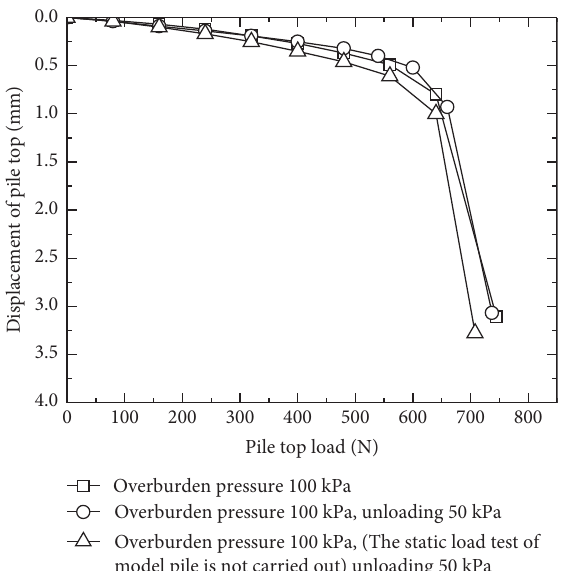
Figure 19: Pile tip pressure versus pile top